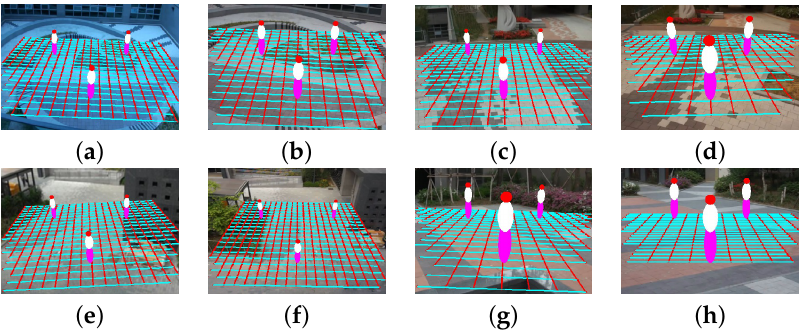
Figure 16. Result of camera calibration on the virtual three-dimensional grid on: ( a , b ) two images of the first scene captured by two different camera parameters; ( c , d ) two images of the second scene captured by two different camera parameters; ( e , f ) two images of the third scene captured by two different camera parameters; ( g , h ) two images of the fourth scene captured by two different camera